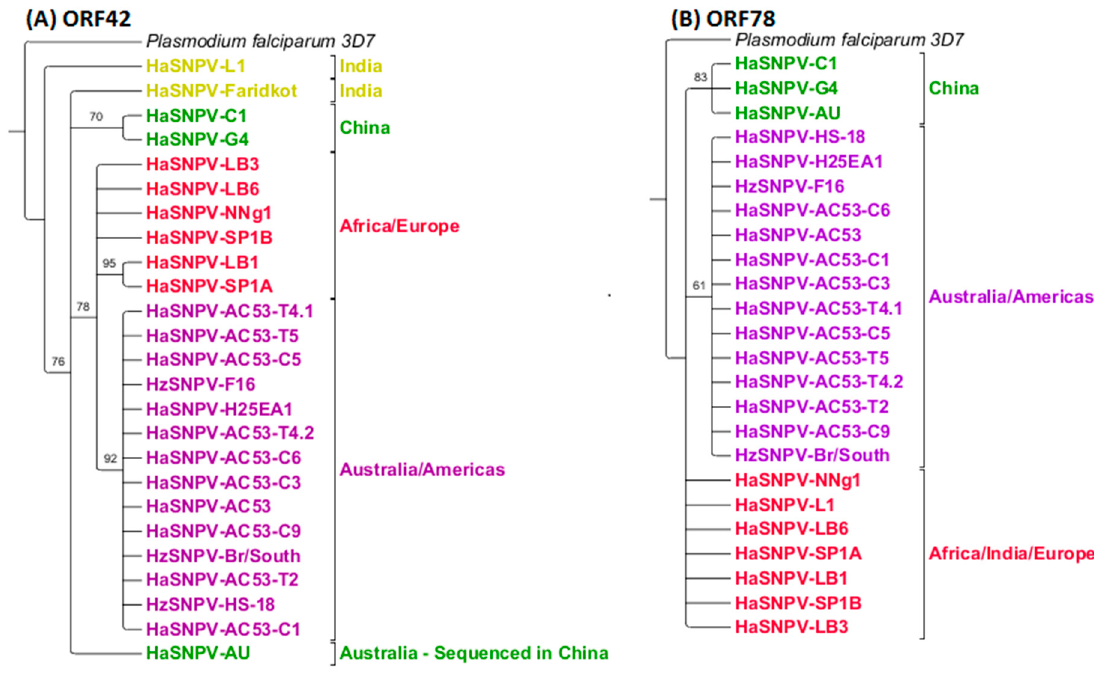
Figure 6. MLEs using ( A ) open reading frame (ORF) 42 and its homologs; and ( B ) ORF78 and its homologs identify the same three geographic clusters as the whole-genome sequences. Both trees have been rooted to Plasmodium falciparum 3D7 with a similar nucleotide sequence to ORF42 and ORF78, and collapsed to 60% minimum support values. Coloring code is identical to Figure 5.